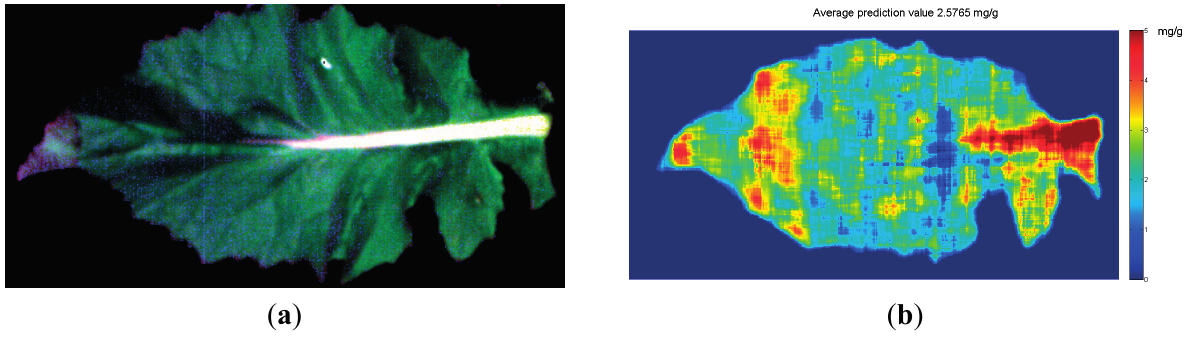
Figure 6. Original RGB image ( a ) and the distribution maps of soluble protein content of oilseed rape leaf (the average predicted value is on the top of the figure) ( b